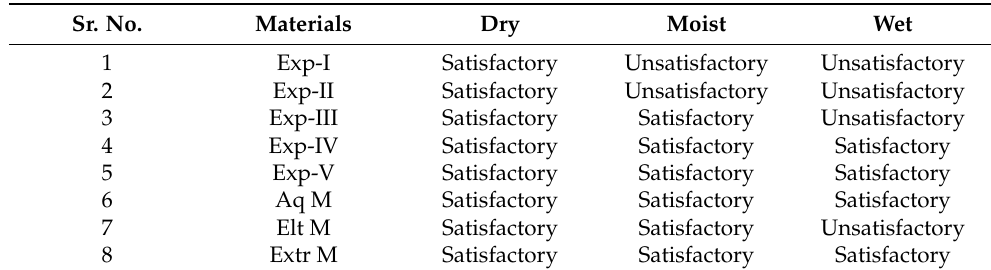
Table 3. Surface detail reproduction for commercial and Exp VPS (medium bodied) impression materials under dry, moist and wet